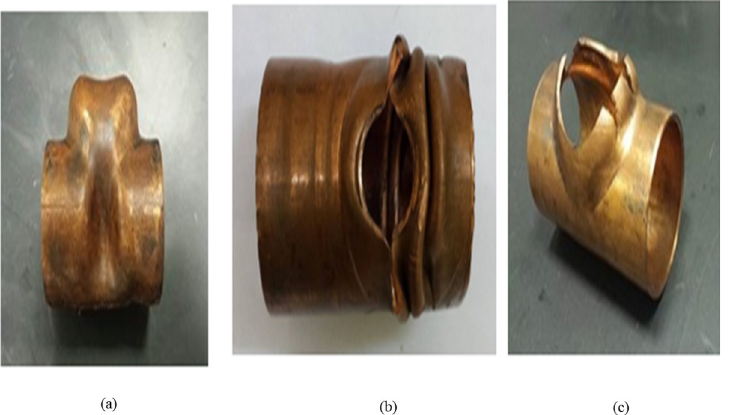
Fig 8. Process failure samples: a) Wrinkling b) Buckling c)